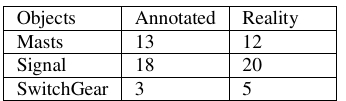
Table 1. The first set of